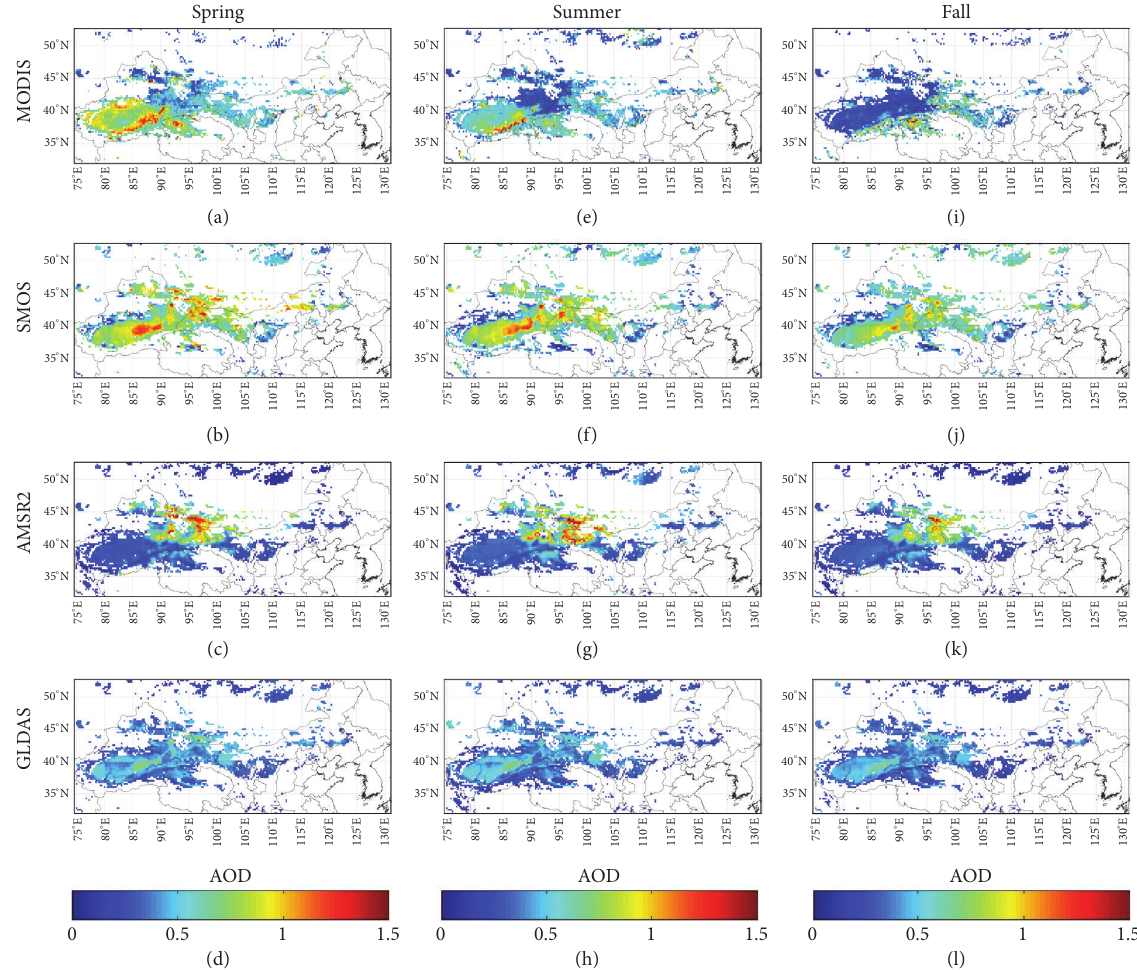
Figure 8: Spatial distribution of seasonal mean for observed and modeled AOD in the desert regions of East